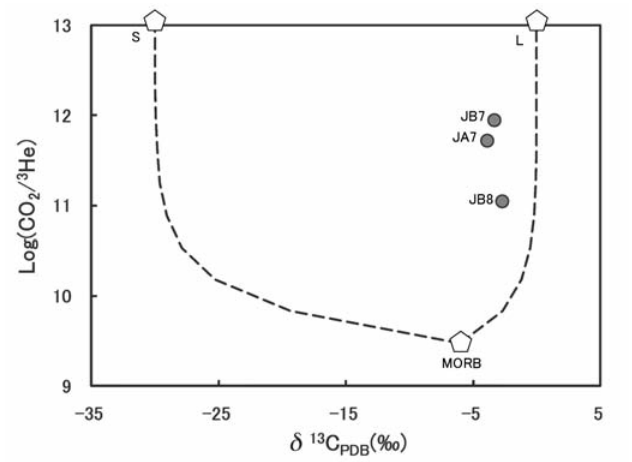
Figure 7. CO / 3 He ratios and δ 13 C values of CO 2 gases from site J. L, S, end members typical of oceanic sediment (S) and oceanic limestone (L), respectively. Dashed curves, mixing between S and MORB and between L and